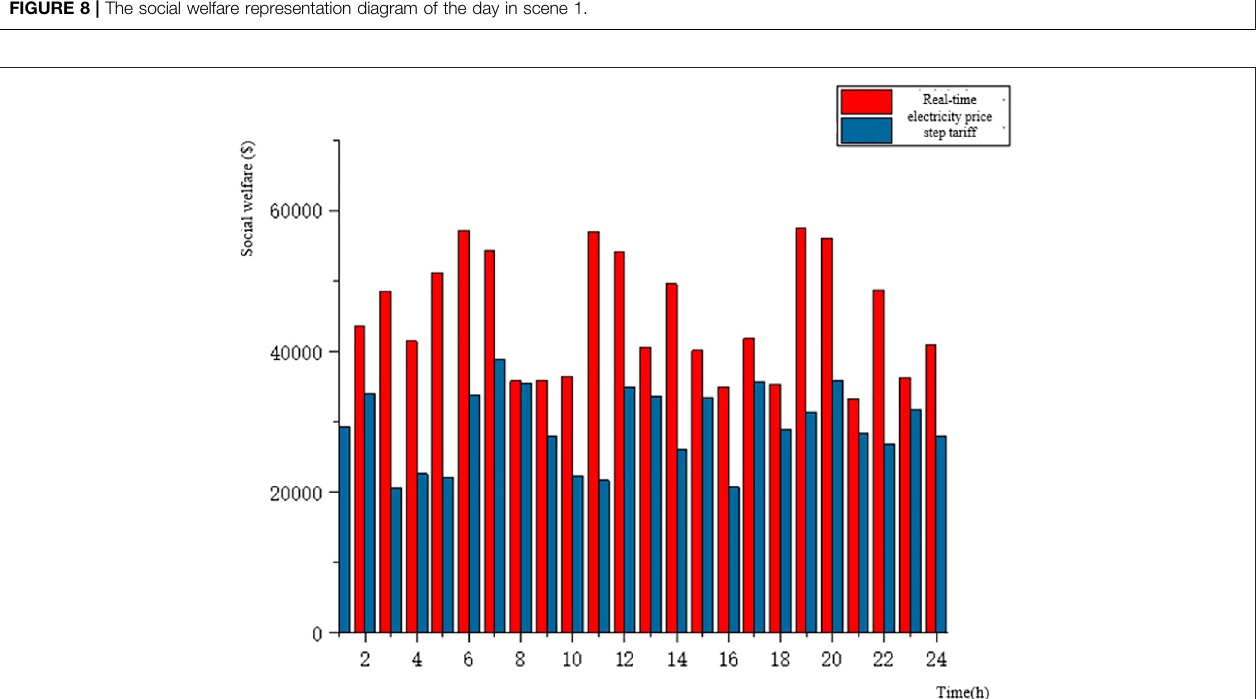
FIGURE 9 | Comparison of social welfare between scene 1 and scene 2.